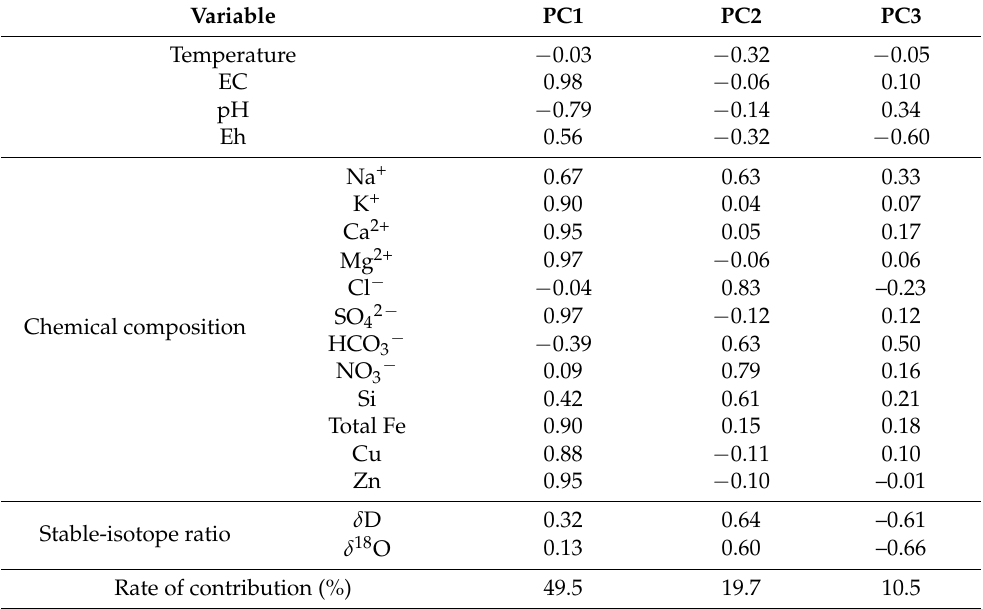
Table 3. Factor loadings and contributions of principal components.